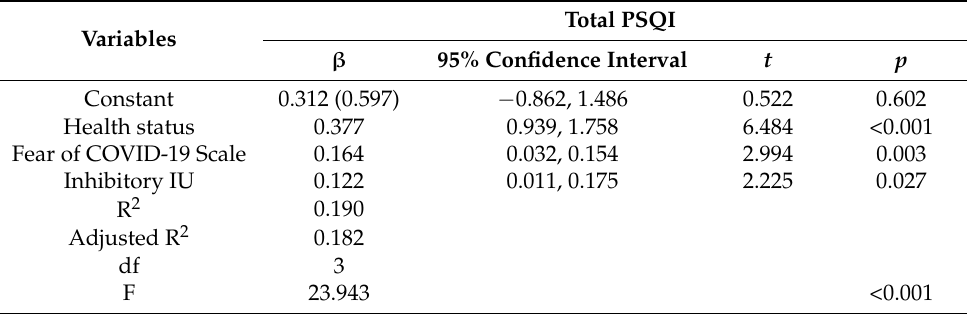
Table 5. Results of the stepwise multiple regression analysis for Total PSQI ( N =